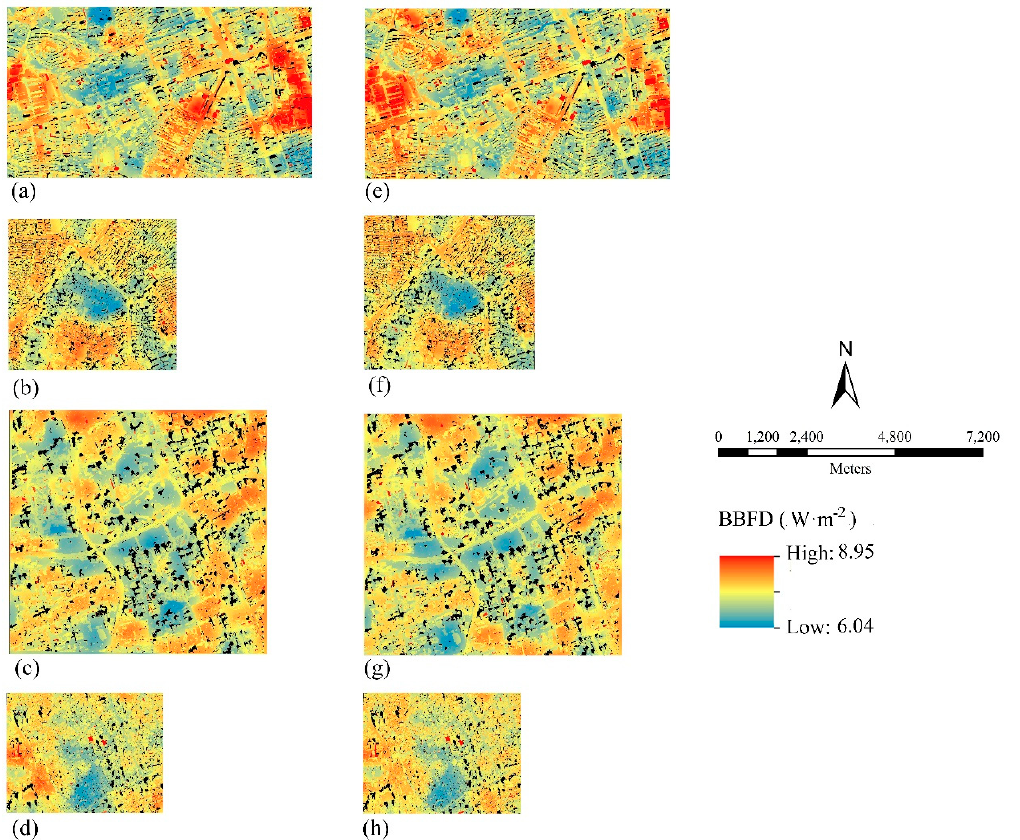
Figure A1. The UFZ-specific BBFD maps on two summertime dates. Note: ( a ), ( b ), ( c ), and ( d ) denote Appendix Figure A1 The UFZ-specific BBFD maps on two summertime dates. the UFZ-specific BBFD (dated on August 13, 2013) at Wujiaochang, PeacePark, UrbanCore, and Xujiahui, respectively. ( e – h ) denotes UFZ-specific BBFD (dated on August 3, 2015),